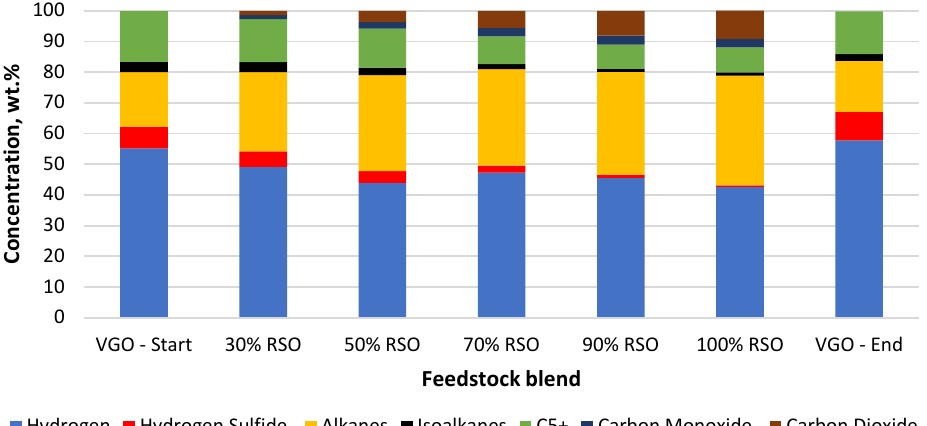
Figure 5. Composition of the main gaseous products collected for each feedstock blend processed using the NiW/Comm. catalyst.